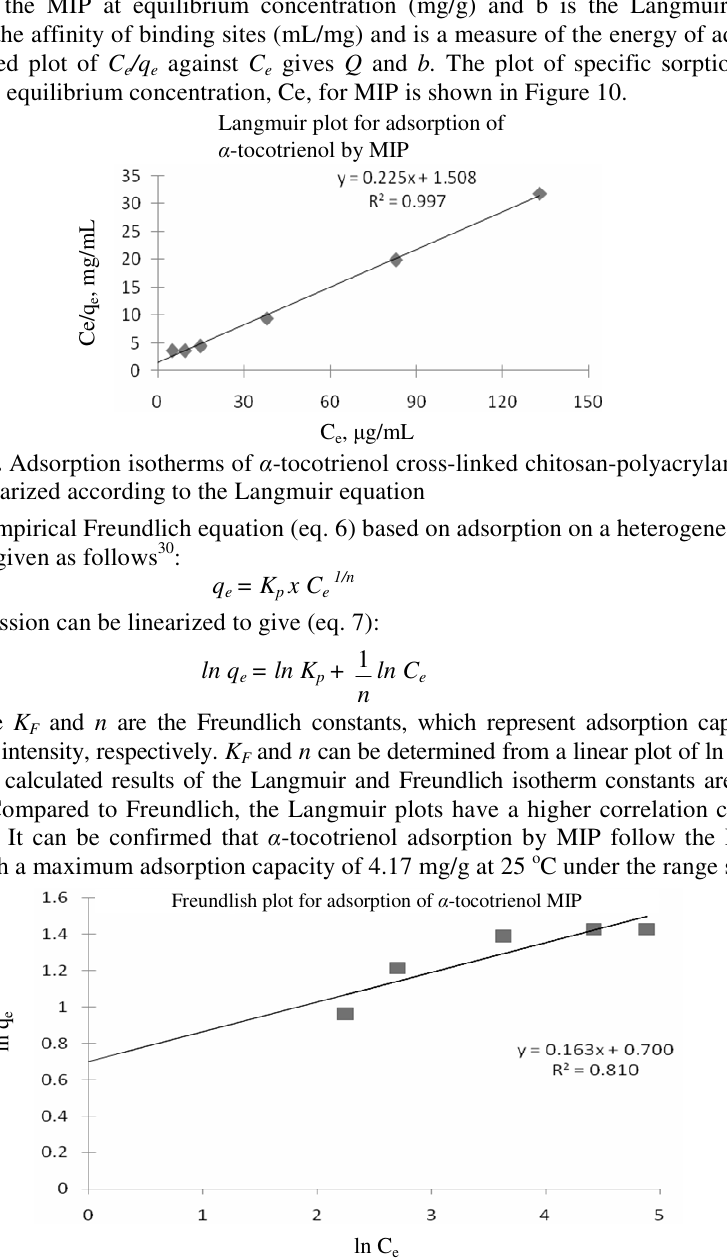
Figure 11 . Adsorption isotherms of α -tocotrienol cross-linked chitosan-polyacrylamide MIP beads, plotted according to the Freundlich equation